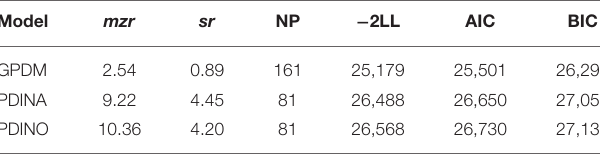
TABLE 7 | Model-data fit comparisons between the saturated and reduced